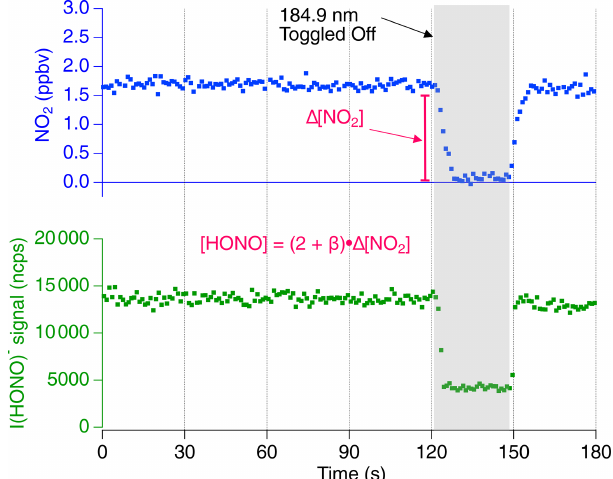
Figure 3. Calibration curve obtained using the NO 2 proxy cal- ibration method at a constant humidity (RH = 17 . 7%, [H 2 O] = 0 . 388% as measured in the CIMS scroll pump exhaust) by varying photon flux F with a Variac variable transformer. Error bars repre- sent ± 2 σ uncertainty. The data were fitted using the York bivariate regression method (York et al., 2004). The y intercept (3820ncps) represents the background CIMS I(HONO) − signal during this cal- ibration and is mostly from impurities in the constant NO addition. Without the NO addition (for ambient sampling), the typical back- ground signal is